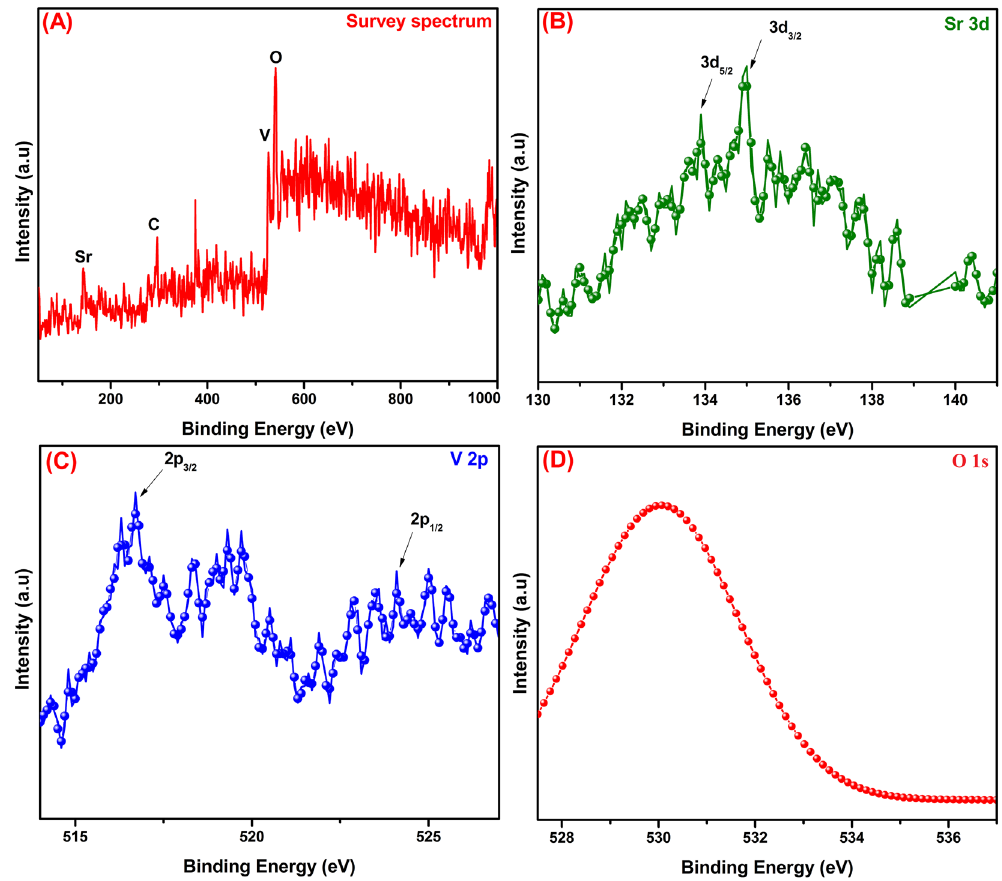
Figure 4. XPS survey spectra of SrV 2 O 6 ( A ),) High resolution XPS spectra of Sr 3d, V 2p and O 1 s ( B – D